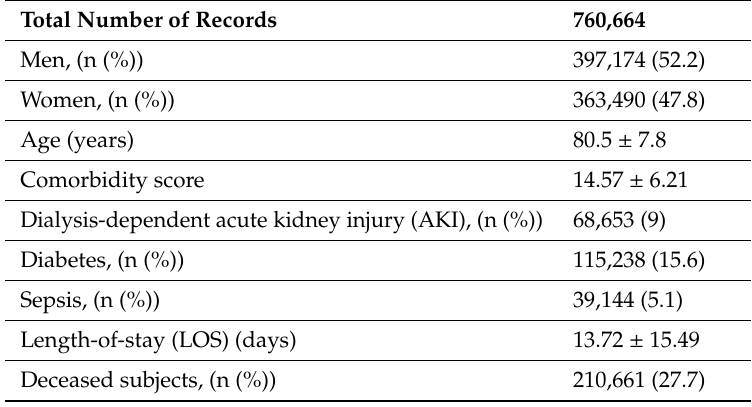
Table 2. Characteristics of the considered population with acute kidney